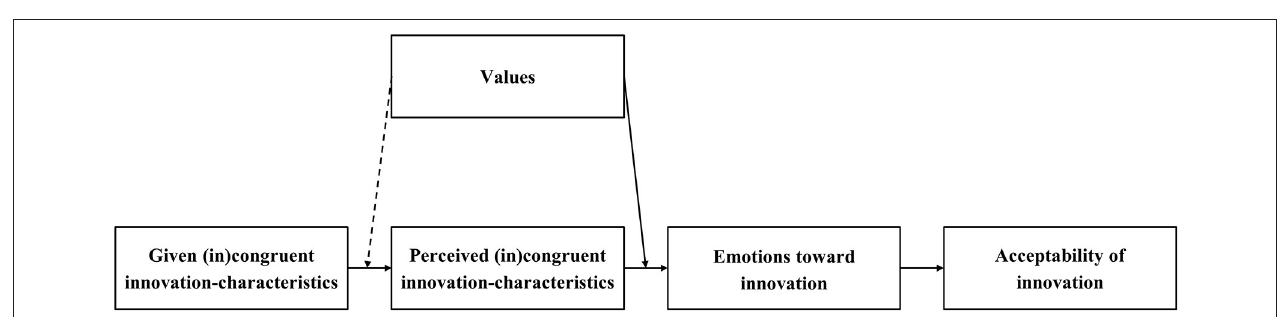
FIGURE 2 | Working model of the present study, applying the VICE model with emotions explaining acceptability of (sustainable) innovations. The potential moderation effect of values on the effect of given on perceived innovation-characteristics (dashed arrow) will also be